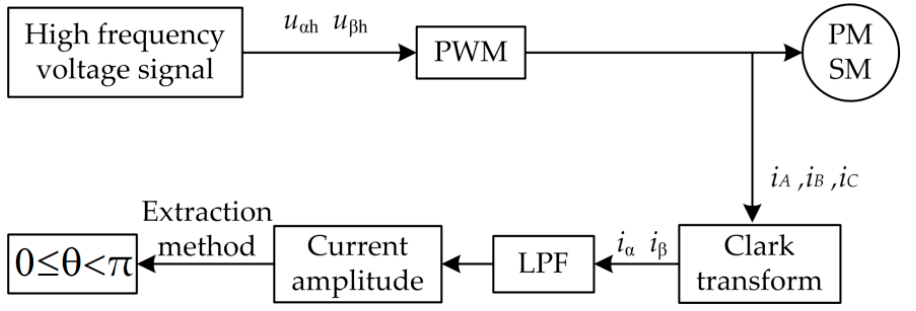
Figure 3. The extraction of rotor position.